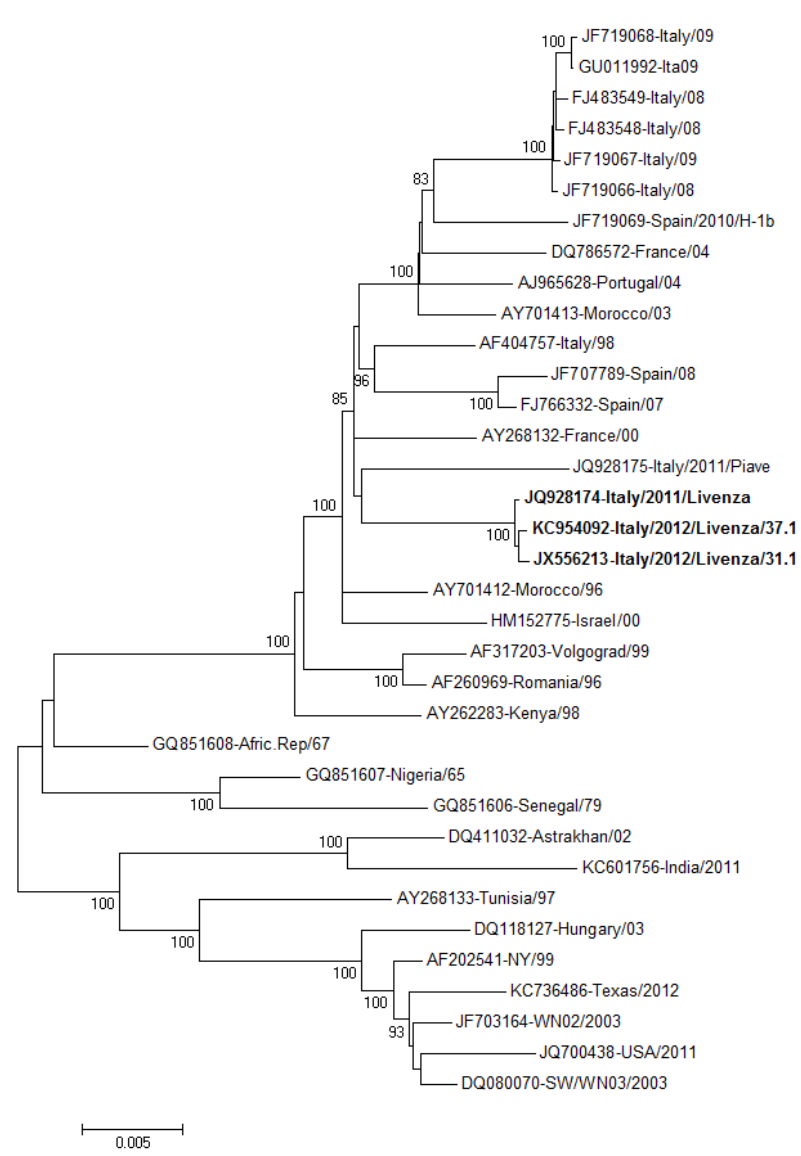
Figure 3. Molecular Phylogenetic analysis of WNV lineage 1 whole genome sequences by Maximum Likelihood method. The evolutionary history was inferred by using the Maximum Likelihood method based on the Kimura 2-parameter model [43]. The percentage of trees in which the associated strains clustered together is shown next to the branches (only for values ≥ 80). The tree is drawn to scale, with branch lengths measured in the number of substitutions per site. The analysis involved 35 nucleotide sequences.